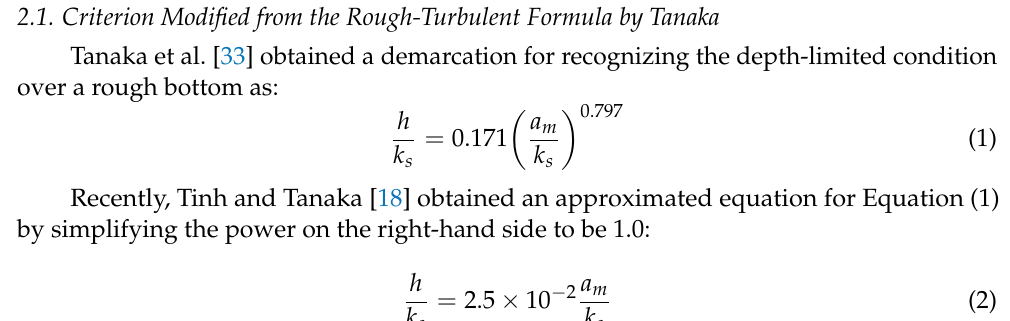
Figure 1. Two types of bottom boundary layer, ( a ) wave boundary layer and ( b ) current type velocity profile.